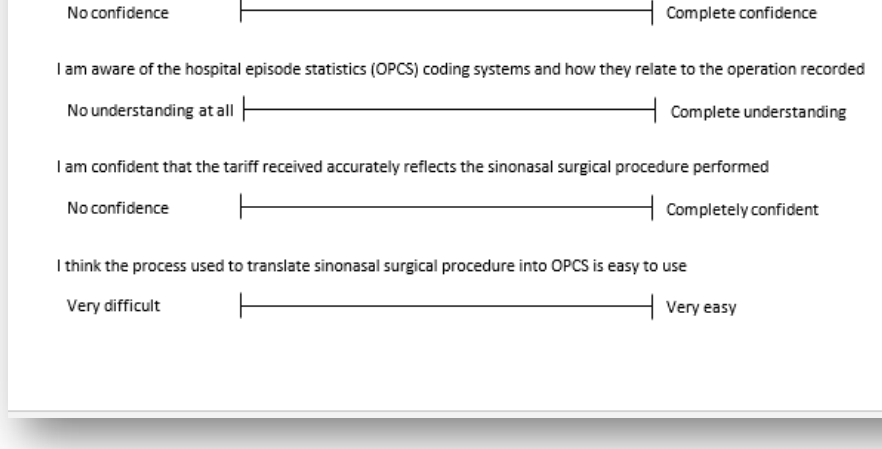
Figure 2. Feedback Figure 2. Feedback questionnaire.